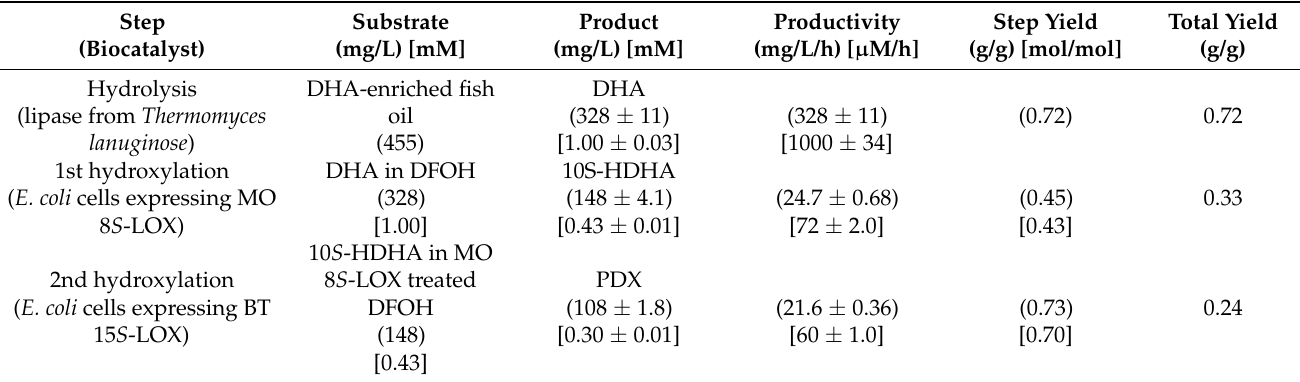
Table 3. Conversion and productivity of PDX from DHA-enriched oil at each